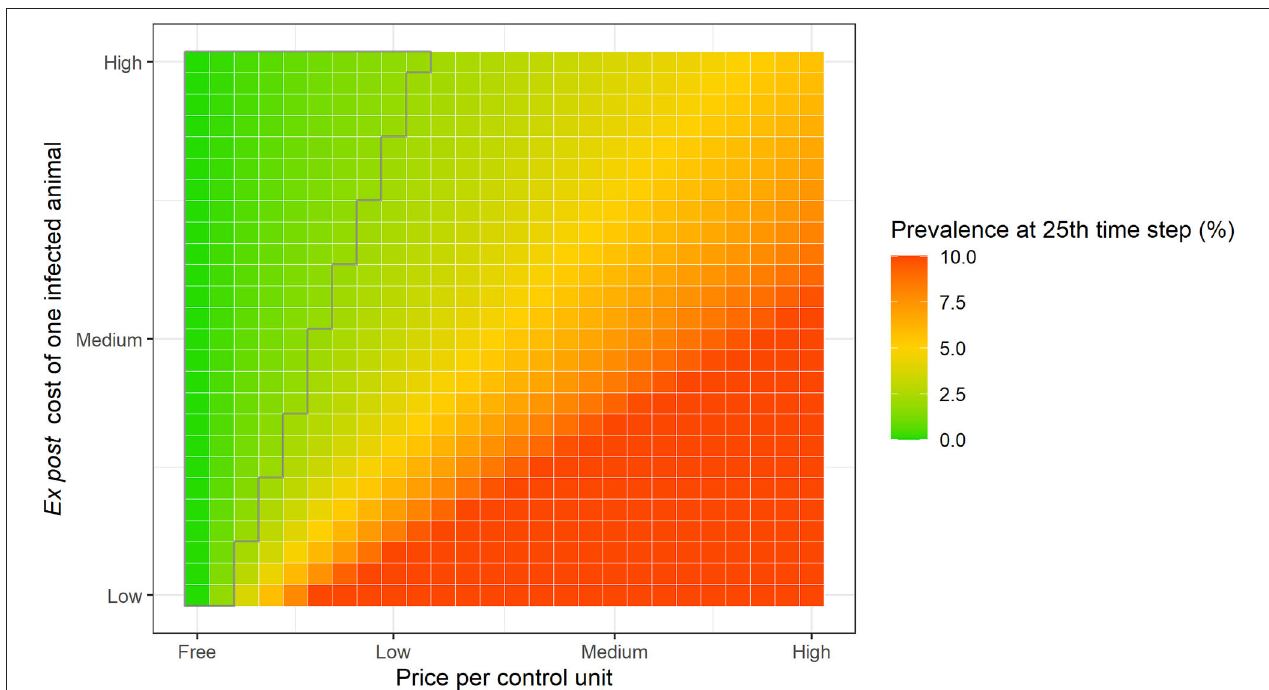
FIGURE 4 | Predicted prevalence at 25th time step for different values of price per control unit (“Free” = 0.00; “Low” = 0.40; “Medium” = 0.85; and, “High” = 1.25 monetary units) and ex post cost per infected animal (“Low” = 10; “Medium” = 46; and, “High” = 85 monetary units), assuming privately optimal behavior in a single farm. The polygon with gray border indicates the target prevalence level from society’s perspective ( <